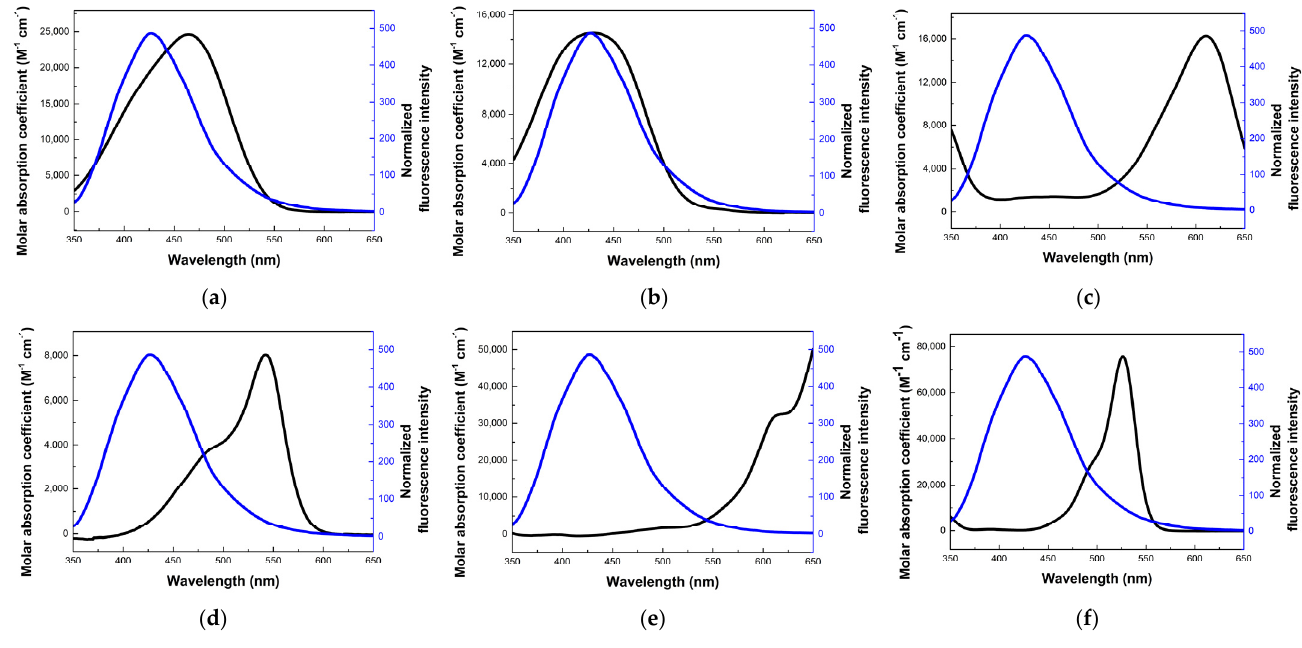
( b ) Figure 8. ( a ) Time-resolved intensity decays (excitation at 340 nm; observation at 426 nm) of WP- CDs (0.1 mg/mL) upon addition of MO in aqueous solution. ( b ) Stern-Volmer plot of the amplitude average lifetimes of WP-CDs in the absence and presence of increasing concentrations of the dye. The origin of the dynamic quenching ought to be explained. A collisional mechanism may again be ruled out because the obtained K D translates into a k qapp of 2.8 × 10 11 M − 1 s − 1 , which is well over that expected for a diffusion-controlled mechanism of fluorescence quenching. On the other hand, considering that the emission spectrum of WP-CDs strongly overlaps the absorption spectrum of MO (Figure 9a), the existence of a non-radi- ative resonance energy transfer (RET) between these partners should be considered as a possible mechanistic pathway to account for the observed reduction of emission under the time-resolved experiment. If such an excited-state event is occurring, it is governed by long-range dipole–dipole excitation energy transfer, as described by the Förster theory [9], requiring very weak coupling interactions between the energy donor (WP-CDs) and the acceptor (MO). In the general description of the RET theory, the rate of energy transfer ( k ET ) from a donor (D) to an acceptor (A) is given by k ET = 1/ τ D × ( R 0 / r ) 6 , where τ D is the lifetime of the D in the absence of ET, R 0 is the critical ET distance (or Förster distance) at